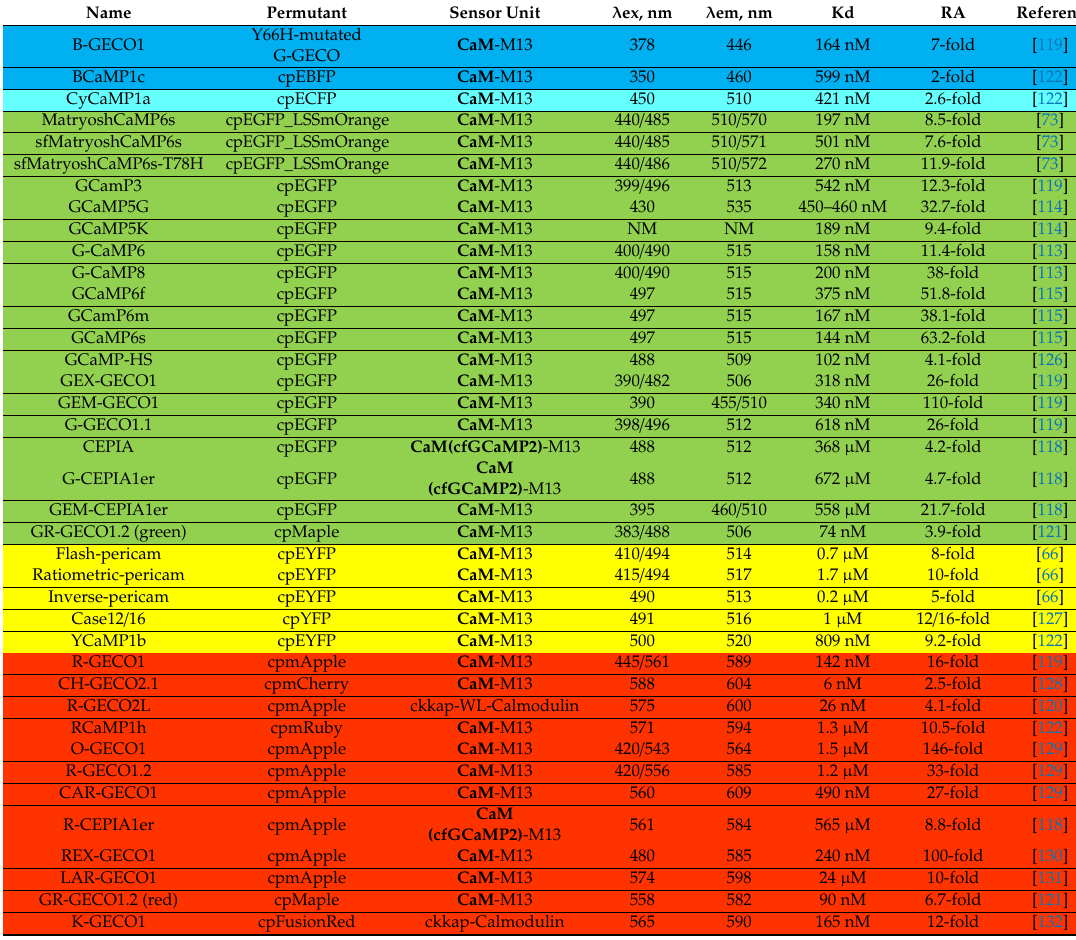
Table 1. Calcium